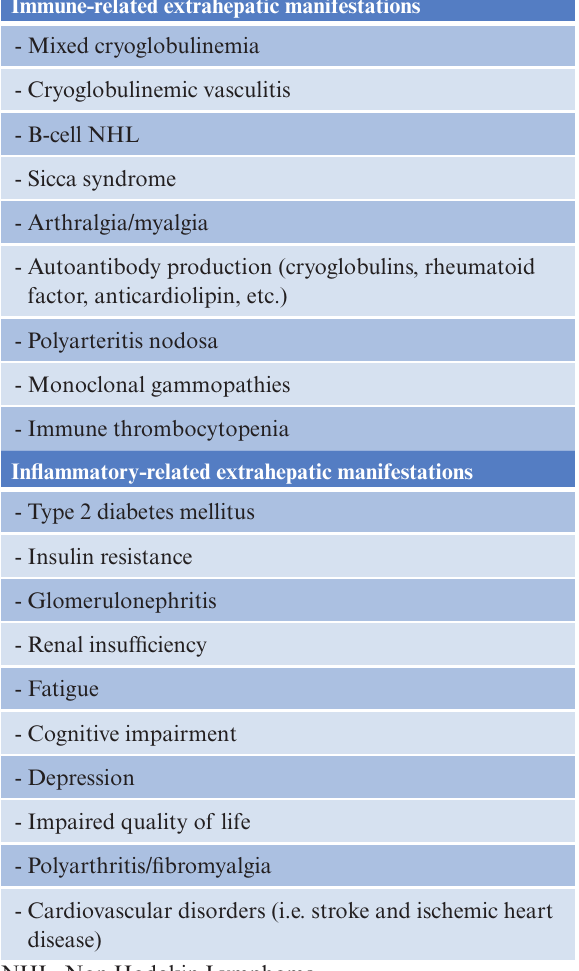
Table 1. The major extrahepatic manifestations in patients with hepatitis C virus infection Immune-related extrahepatic